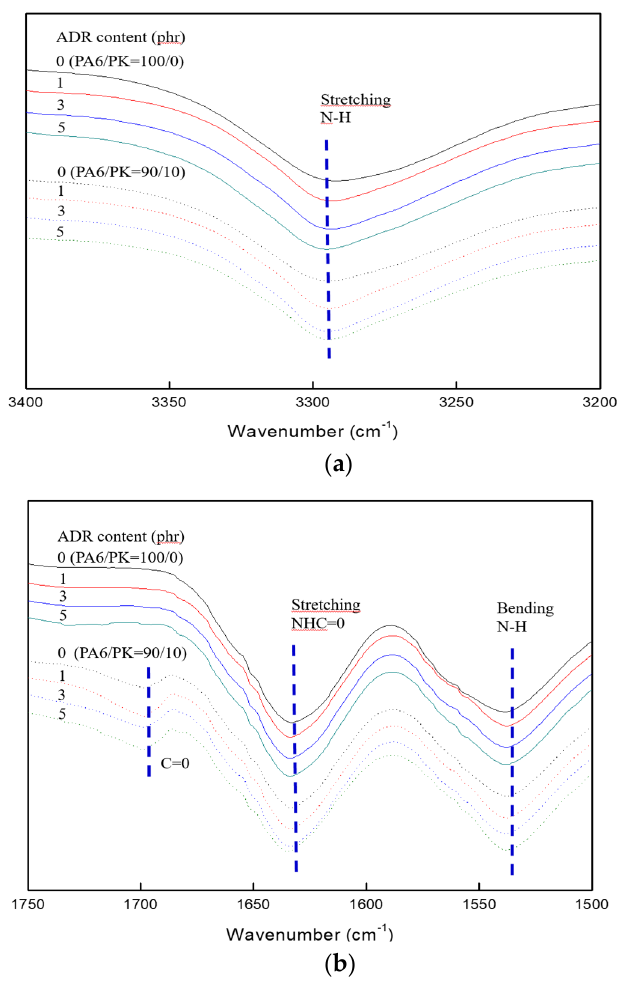
Figure 4. FTIR spectra of PA6 and PA6/PK blend (90/10) of different ADR contents: ( a ) N–H stretching (3294 cm − 1 ); ( b ) C=O (1699 cm − 1 ), NHC=O stretching (1634 cm − 1 ), NHC=O stretching (1634 cm − 1 ), N–H bending(1538 cm − 1 ).